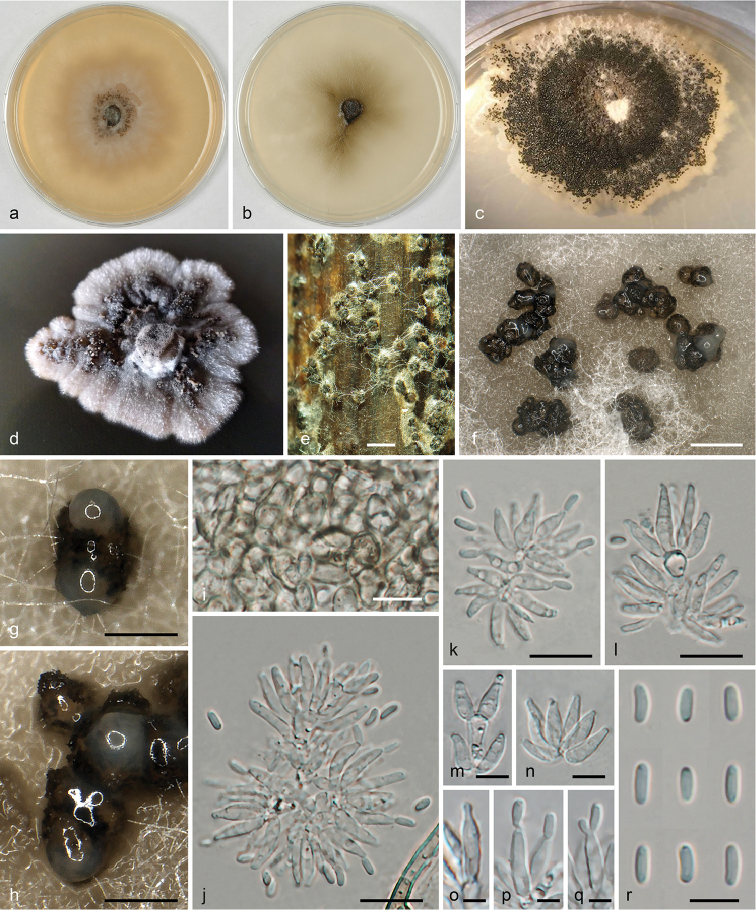
Liberomycespistaciae. a–d Cultures (aMEA, 6 weeks, 22 °C bCMD, 6 weeks, 22 °C cPDA, 3 weeks, 25 °C dPDA, 2 weeks, 25 °C) e Pycnidia produced on artificially inoculated sterilised pistachio twigs f–h Pycnidia in face view on MEAi Pycnidial wall in face view j–n Conidiophores and conidiogenous cells o–q Conidiogenous cells (o young p, q showing sympodial conidiation) r Conidia. All in water. Sources: a–c, f–r ex-holotype strain ISPaVe1958 = CBS 128196 d, e PV1= CPC 31292. Scale bars: 500 µm (e, f); 200 µm (g, h); 10 µm (i–l); 5 µm (m–r).